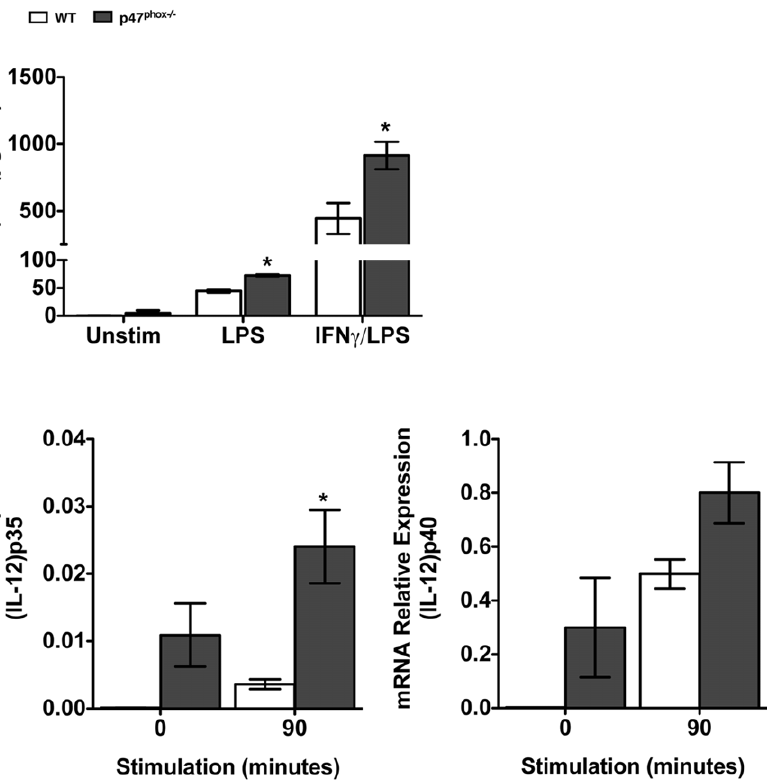
Figure 1. Enhanced IL-12p70 secretion by ROS deficient p47 phox 2 / 2 DC. One million immature DC were cultured in media alone (0) or primed with IFN c for 3 hours then stimulated with LPS for 90 minutes as indicated. (A) Secreted IL-12p70 detected in supernatants of overnight cultures of immature, LPS and IFN c /LPS stimulated DC. The data are the mean ( 6 SEM) percentage for 5 individual experiments with 3–4 of each genotype/experiment. *p # 0.01, n=5. (B) Immature DC were cultured in media alone or primed with IFN c for 3 hours then stimulated with LPS 90 minutes as indicated. Following RNA extraction, IL-12p35 and IL-12p40 expression was quantitated by real-time PCR. The data are the mean ( 6 SEM) percentage for 3 individual experiments with 3–4 of each genotype/experiment. *p ,